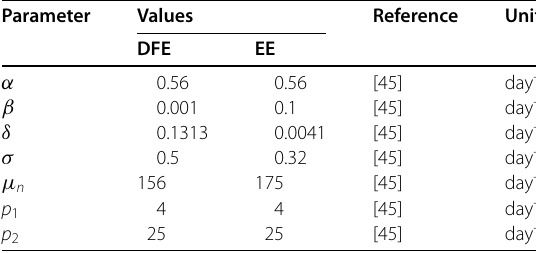
Table 1 Parameters used and their values Parameter Values